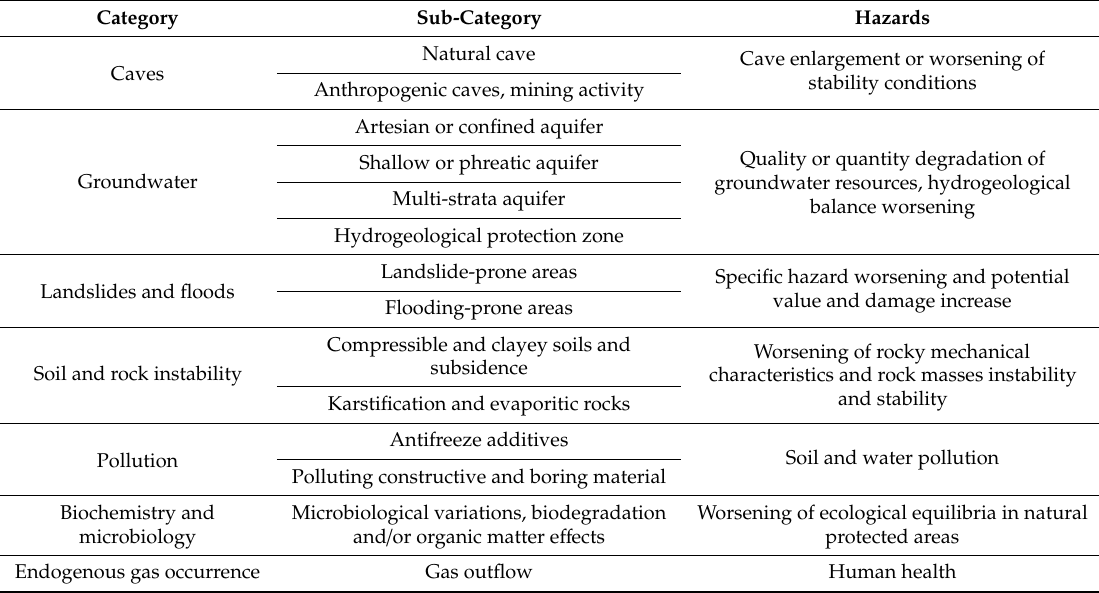
Table 3. Summary of hazard sources to be considered for